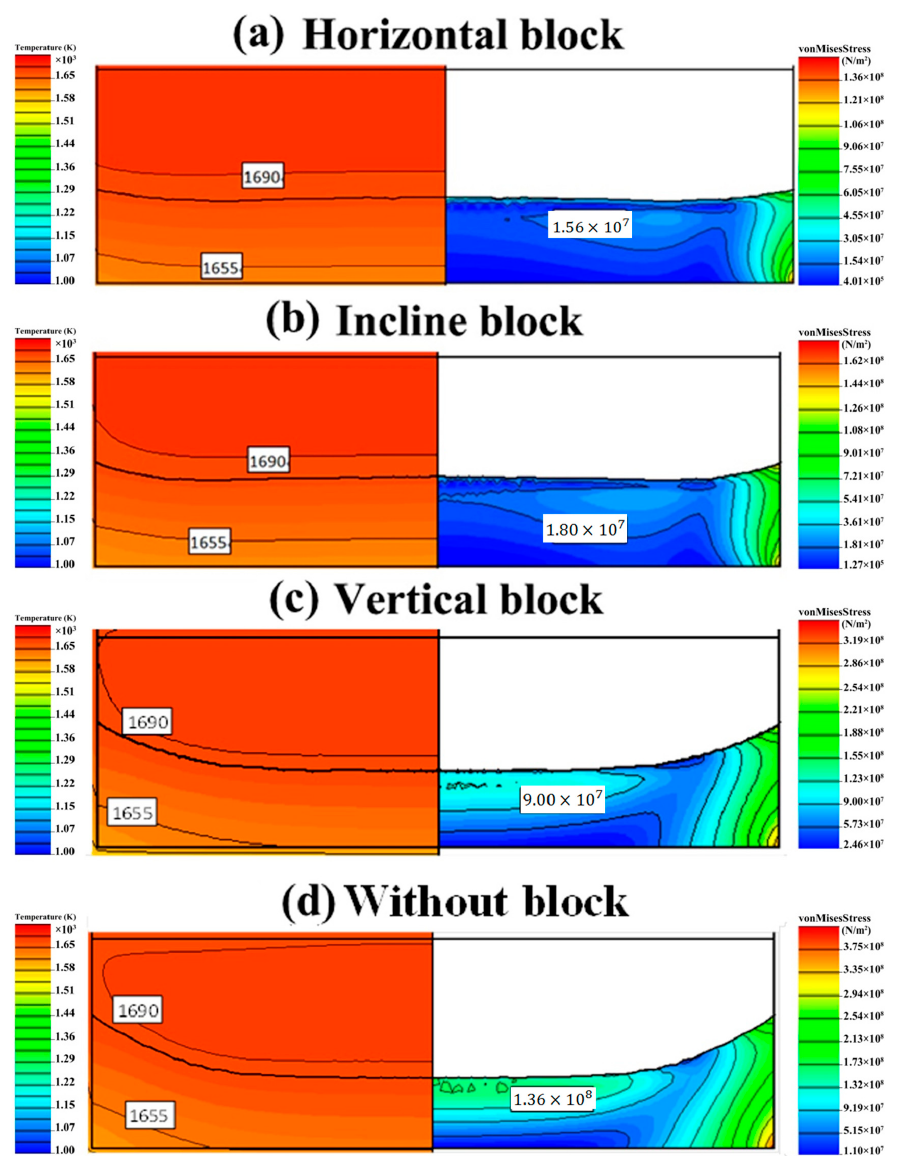
Figure 10. ( e – h ) Temperature and thermal stress distribution for different block positions at the half stage. Figure 10. ( a – d ) Temperature and thermal stress distribution for different block positions at the half stage.